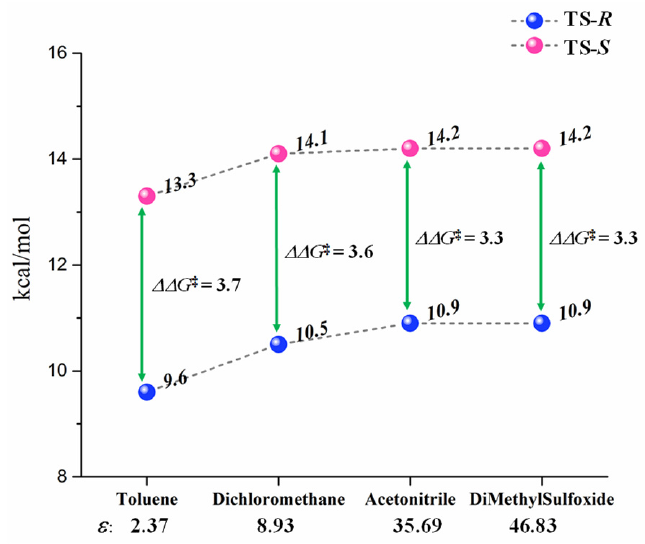
Figure 5. Activation barriers of TS- R/S and their di ff erences for − OCH 3 substituted imine in various solvents.